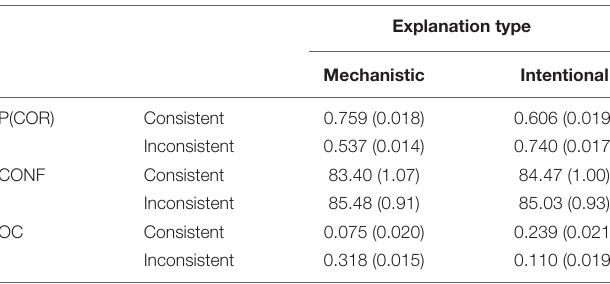
TABLE 3 | Proportion correct [P(COR)], mean confidence (CONF), and overconfidence (OC) for explanation type and consistency for Experiment